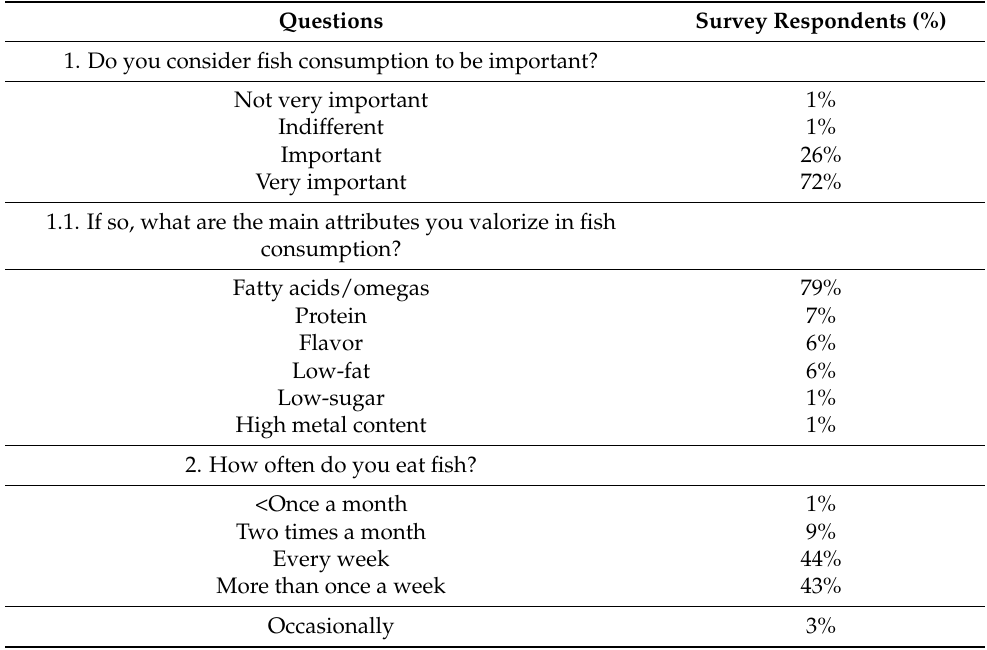
Table 2. Results of the survey concerning the importance and frequency of fish consumption and its main reason, as well as the presence of fish with low or absent commercial value in the consumers diet ( n =